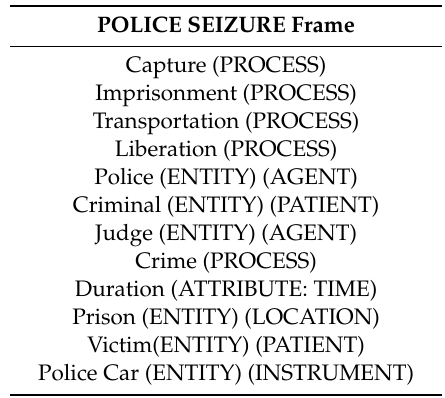
Table 2. Frame elements of POLICE SEIZURE